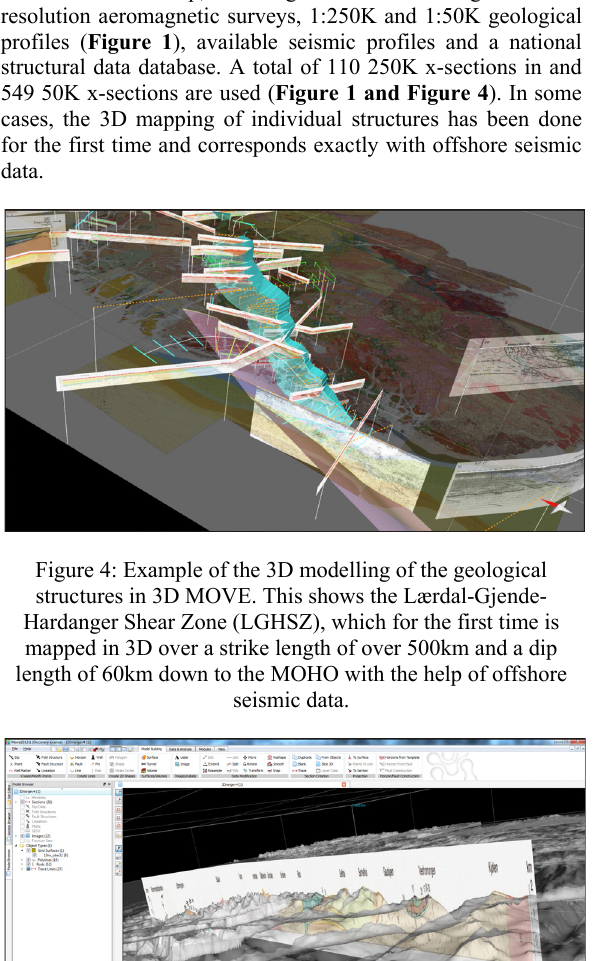
Figure 8: Screen dump from 3DMOVE showing two intersecting 250K profiles that